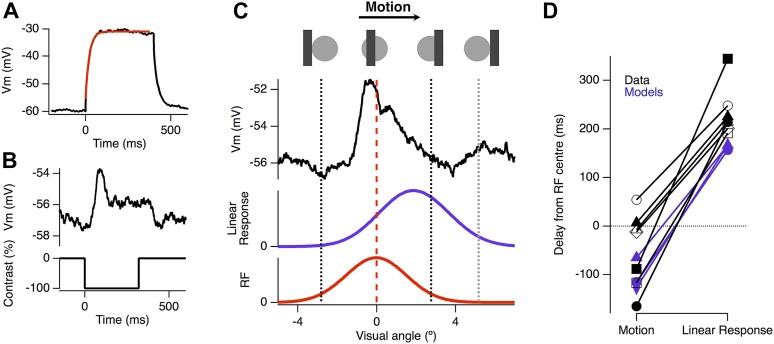
Motion anticipation is evident in the EPSPs of ganglion cells with passive dendrites.(A) Ganglion cells were dialyzed with 2 mM MK801 and 10 mM QX-314-Bromide. The efficacy of these drugs was assessed by attempting to fit a large step depolarization with a single exponential; the depolarization was well fit after 10 min of dialysis. (B) The EPSP evoked by a 160 µm (2.4º) bar flashed for 320 ms over the RF centre of the same ganglion cell in a with passive dendrites. (C) Example of the EPSP recorded as a bar moves across the receptive field of an OFF ganglion cell (average of 10 presentations). The EPSP is plotted as a function of the bar's location within the RF and the purple trace below, shows the expected linear response obtained by convolution of the EPSP from B with the RF. (D) The average delay for EPSPs in RGCs with passive dendrites was −47.2 ± 29.4 ms, whereas the expected linear response was always delayed with an average of 233.84 ± 19.6 ms (n = 7, p = 0.0002). The delays for the three models are shown in purple, with the linear response representing the model with only excitation.